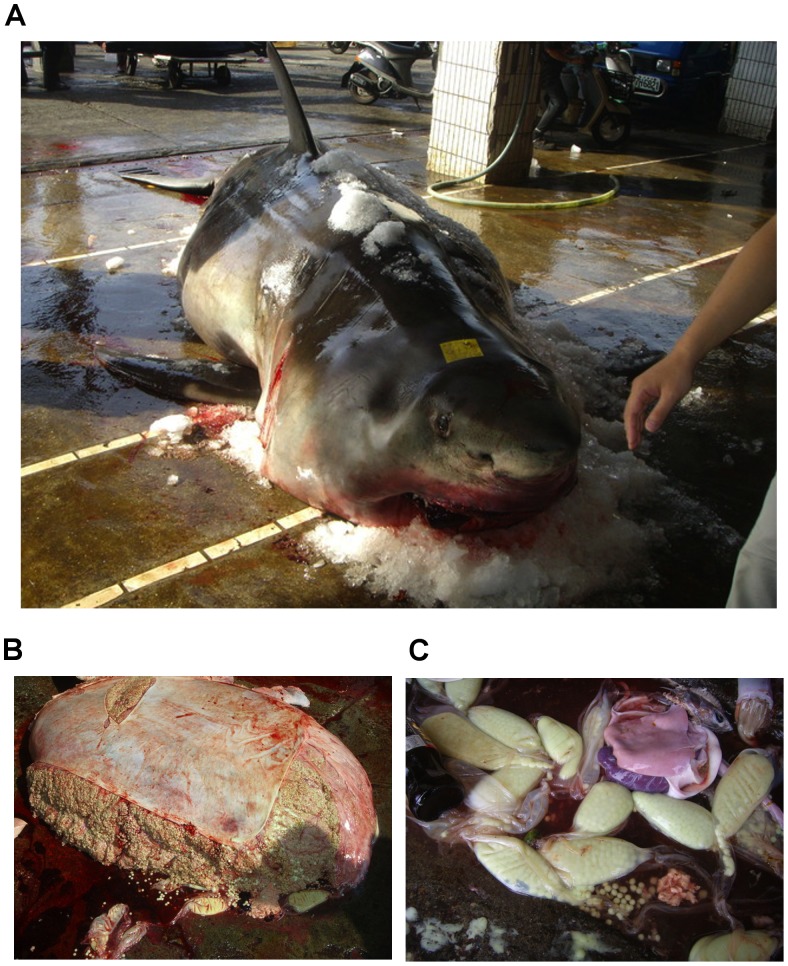
Pregnant white shark.A) Pregnant female captured on November 7, 2008 in Southern Bay Dock, East Taiwan, measuring 542 cm total length and weighing 1930 kg B) Ovary C) Egg cases measuring 10 cm. Photos obtained from: http://tw.m.wretch.yahoo.com/album/redo0905/12.